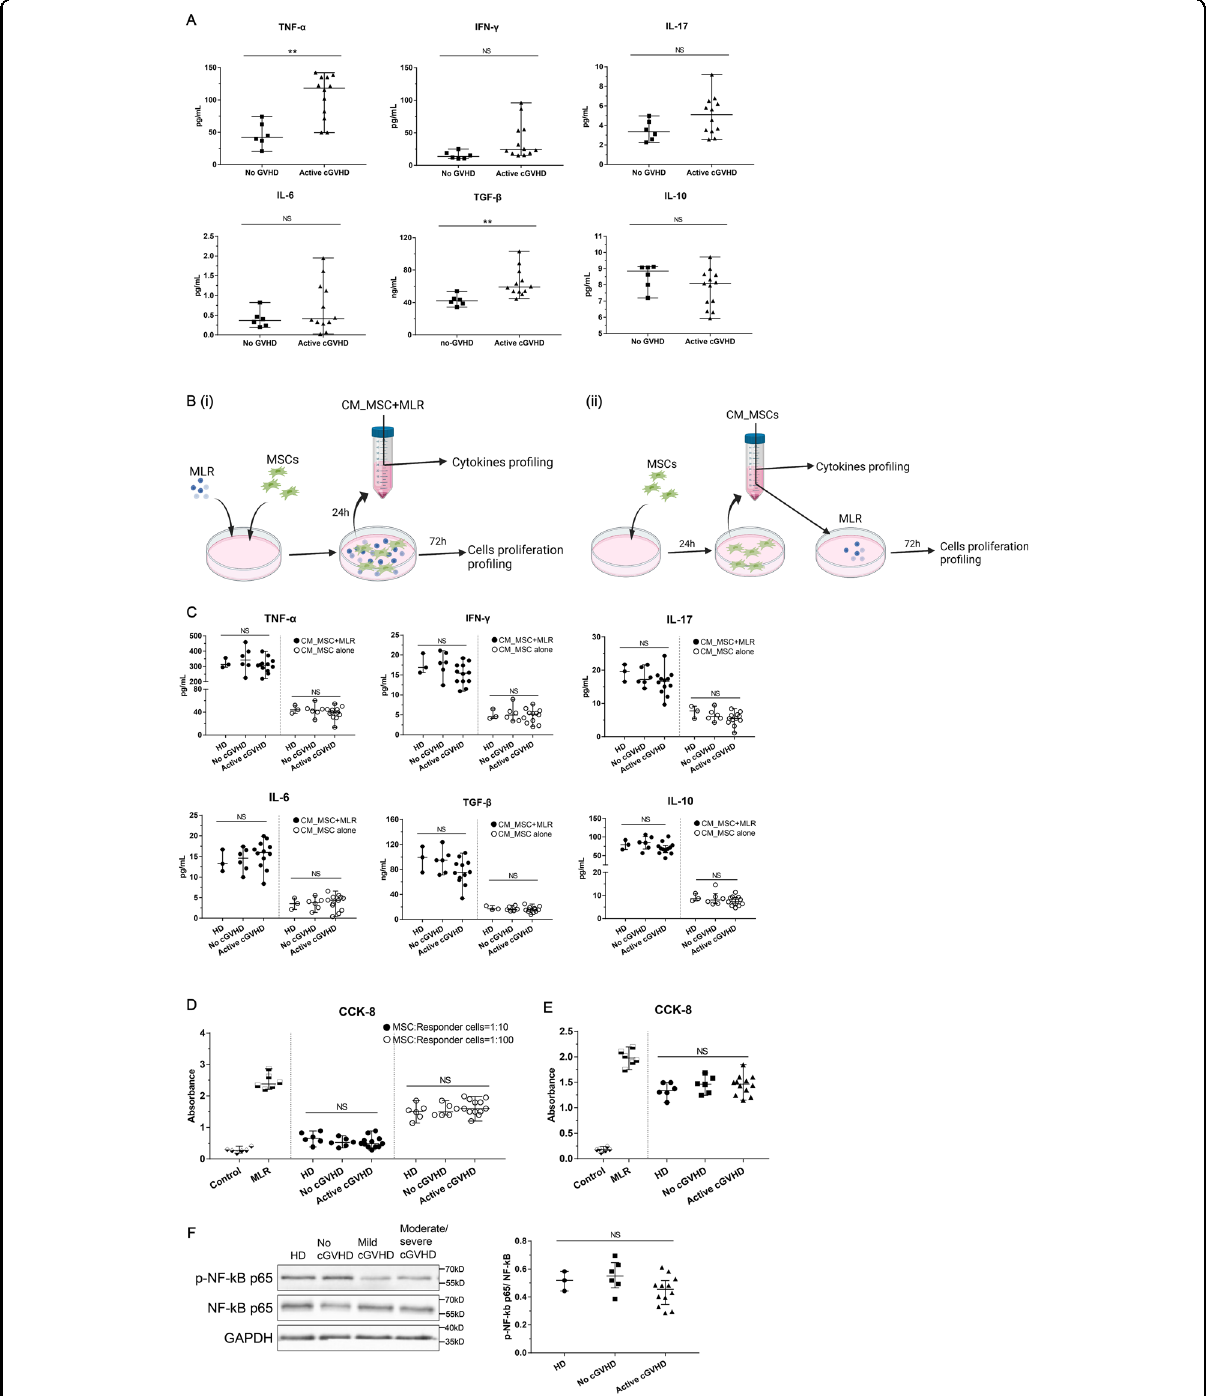
Fig. 6 Immunomodulation of MSCs. A The levels of IL-6, IL-10, IL-17, TNFa, IFN-r, and TGF-b in bone marrow serum from no cGVHD and active cGVHD patients. B Schematic diagram showing (i) the MSC co-cultrued with MLR conditioned medium collection process and (ii) CM_MSC cultrued with MLR conditioned medium collection process. C The levels of IL-6, IL-10, IL-17, TNFa, IFN-r, and TGF-b in the conditioned medium of cell-cell cocultured and MSCs cultured alone. D The immunosuppressive function of different concentrations of cocultured MSCs from HD, no cGVHD, and active cGVHD patients. E The paracrine immunosuppressive function of MSCs conditioned medium with MLR. F Representative protein expression of NF-kB, p-NF-kB, and GAPDH in MSCs derived from healthy donors, patients without cGVHD and patients with active cGVHD. HD-MSCs ( n = 3), no cGVHD-MSCs ( n = 6), and active cGVHD-MSCs ( n = 12). Black bars in each fi gure represent the median ± range. NS, not signi fi cant. * P < 0.05, ** P < 0.01, *** P < 0.001, and **** P <